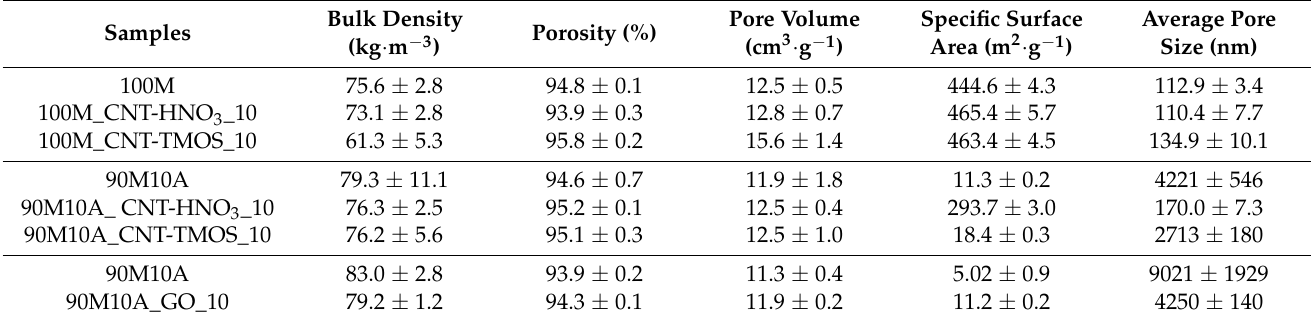
Table 2. Summary of physical and microstructural properties of the synthesized silica aerogels and carbon nanostructures–silica aerogel composites with 0.83 wt.% of surfactant. Adapted with permission from ref. [50]. Copyright (2019)